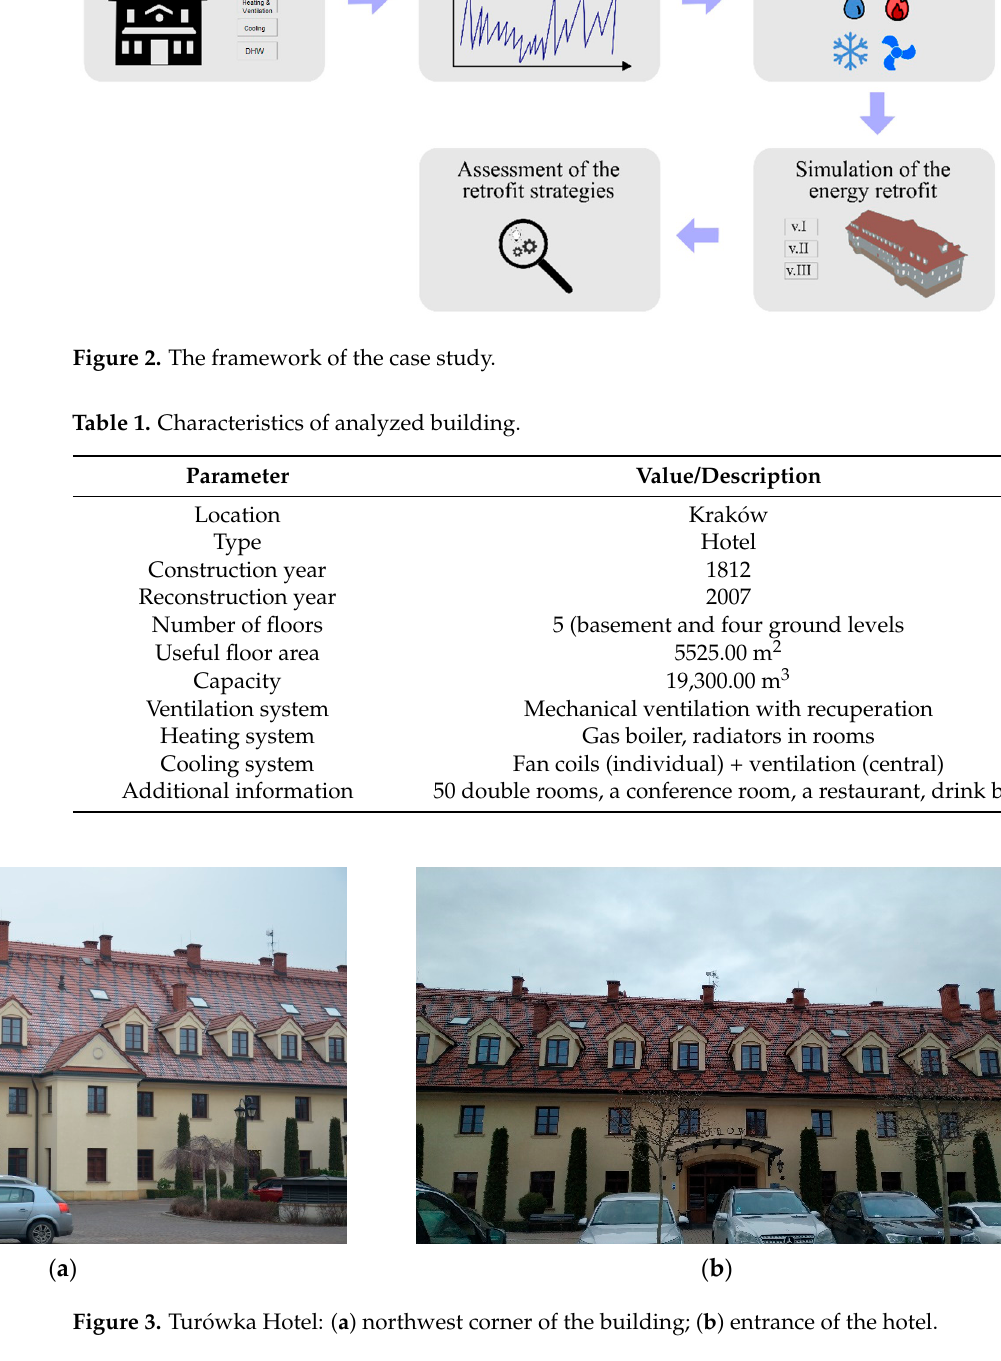
Figure 3. Turówka Hotel: ( a ) northwest corner of the building; ( b ) entrance of the hotel. Figure 3. Tur ó wka Hotel: ( a ) northwest corner of the building; ( b ) entrance of the